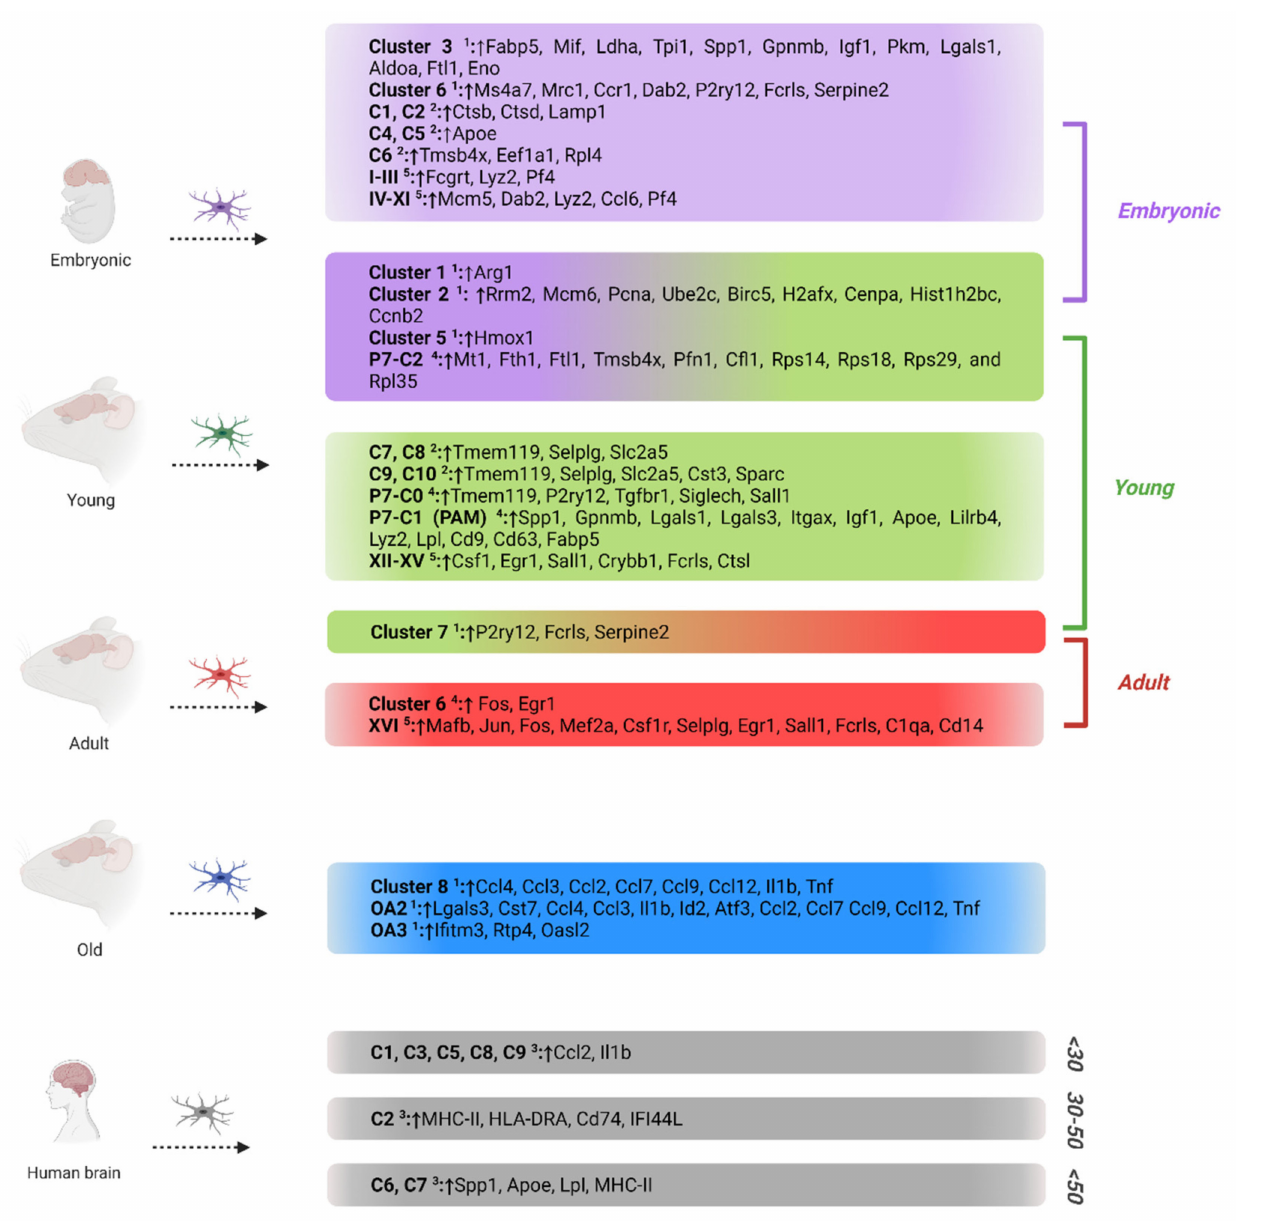
Figure 2. Overview of the most distinct age-associated microglial populations and their transcrip- tomic signatures revealed through transcriptional profiling of murine and human microglia us- ing single-cell RNA sequencing. Microglial subsets are represented with superscript numbers as described in the studies of 1 Hammond et al. [15], 2 Masuda et al. [16], 3 Sankowski et al. [18], 4 Li et al. [39], 5 Matcovitch-Natan et al. [40]. ↑ denotes transcriptomic upregulation. Figure created with BioRender.com (accessed on 18 June